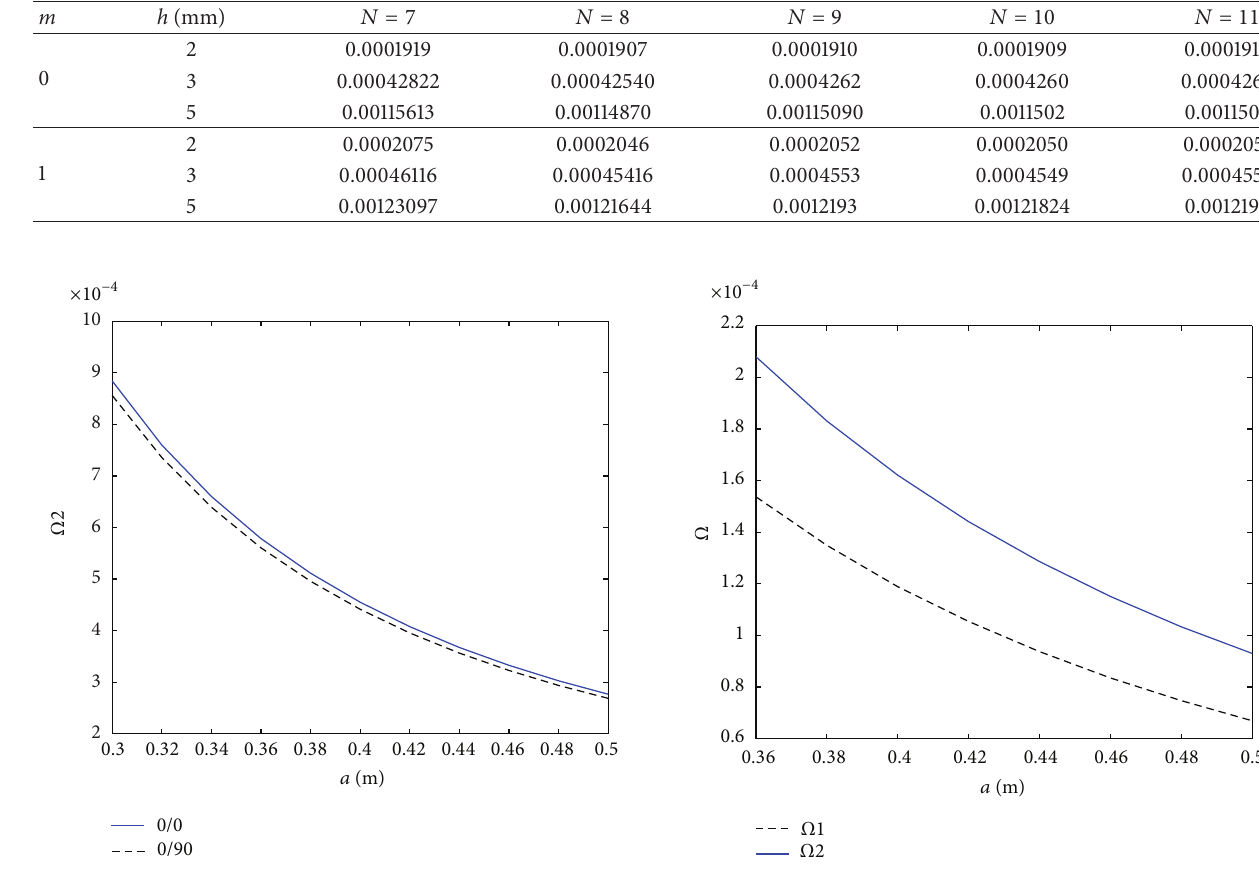
Figure 10: Variation of the first and second mode natural frequen- cies with the radius of the plate for the simple-simple boundary condition ( 𝑏 = 0.05 m and ℎ 𝑐 = 0.0005 m).